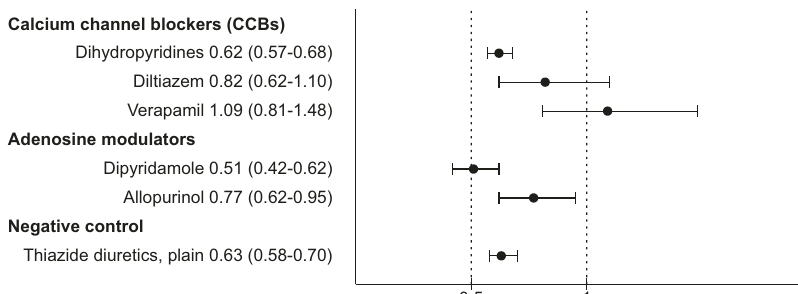
Fig. 3 All-cause mortality associated with add-on drug use, adjusted between-individual model. Hazard ratios with 95% con fi dence